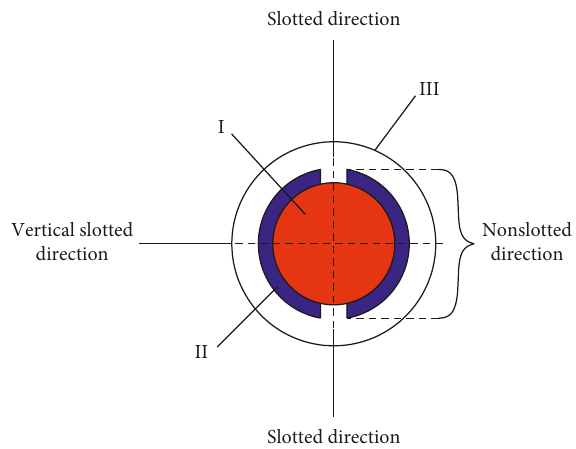
Figure 1: The charge structure in the directional fracture blasting with slotted cartridge: (I) explosive; (II) slotted pipe; (III)